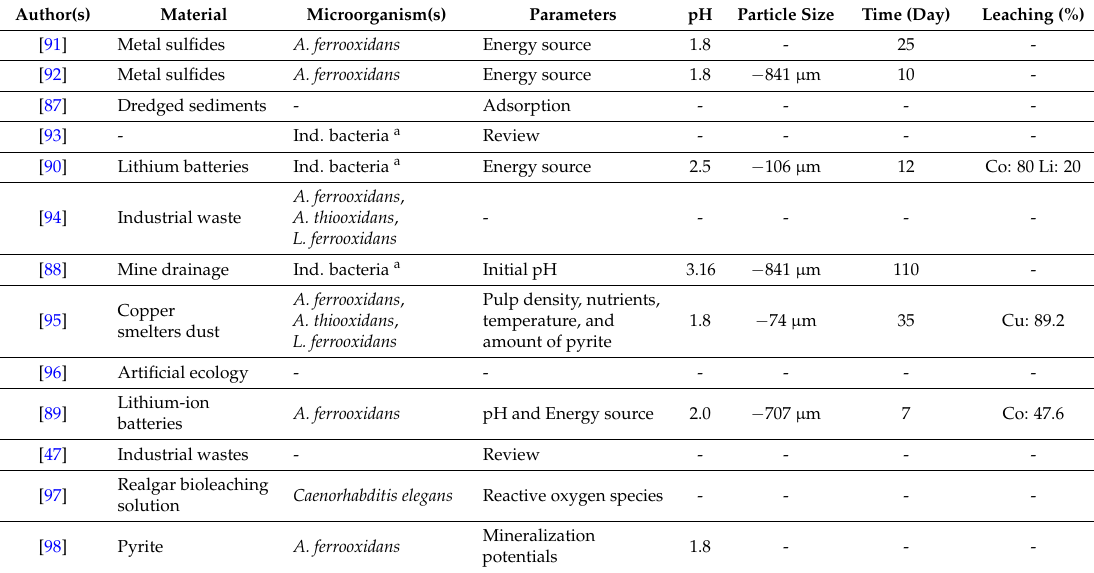
Table 7. Bioleaching research of other materials’ research according to the parameters and materials studied as well as recoveries achieved. The table presents the microorganisms used for the studies. The articles appear in chronological